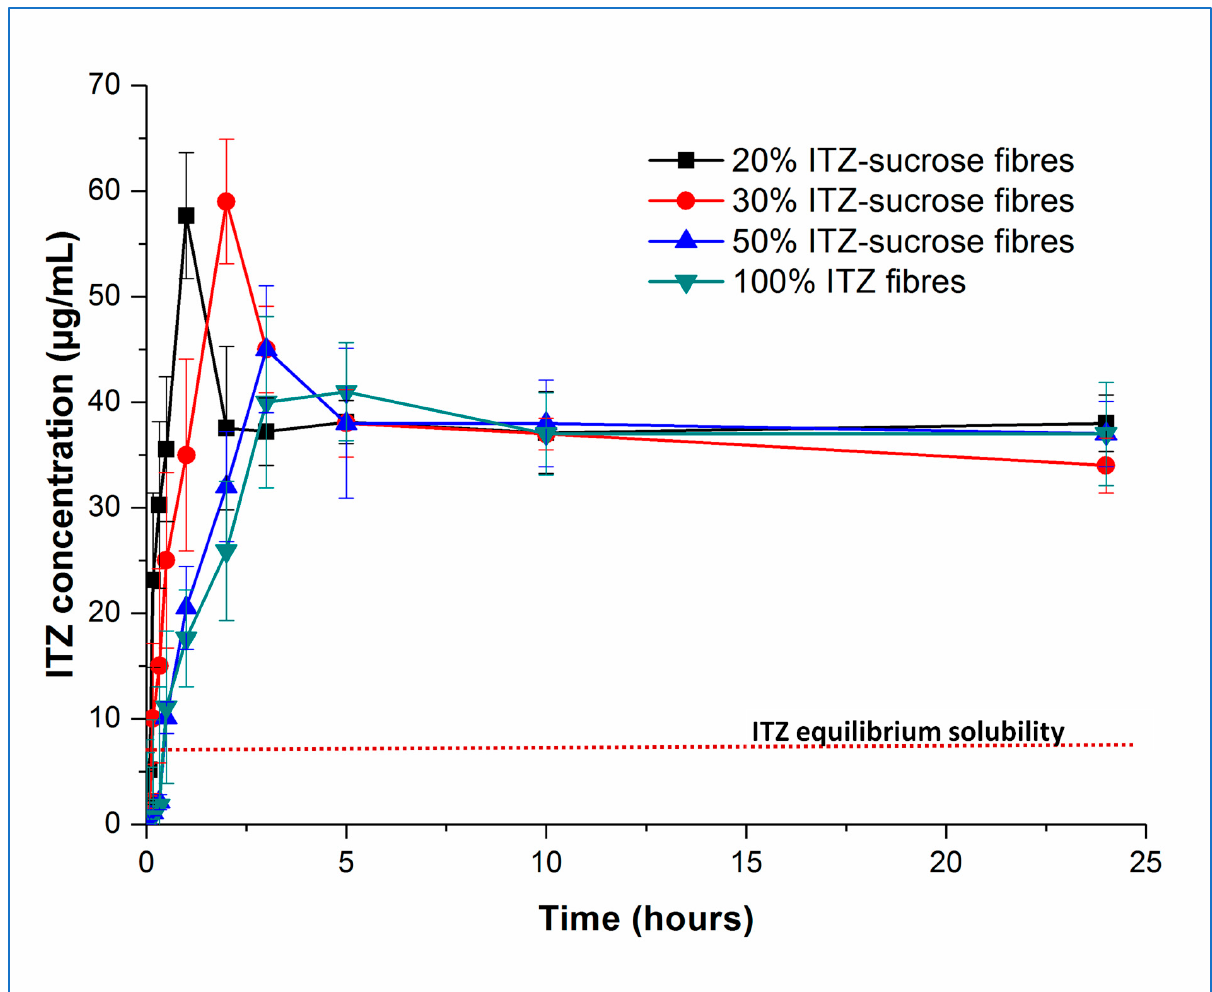
Figure 6. Dissolution–supersaturation profiles obtained under non-sink conditions for freshly pre- pared itraconazole-loaded sucrose microfibres (containing 20, 30, and 50% w / w itraconazole) and pure itraconazole microfibres. The red dotted line indicates the equilibrium solubility of crystalline itraconazole. (ITZ = itraconazole).